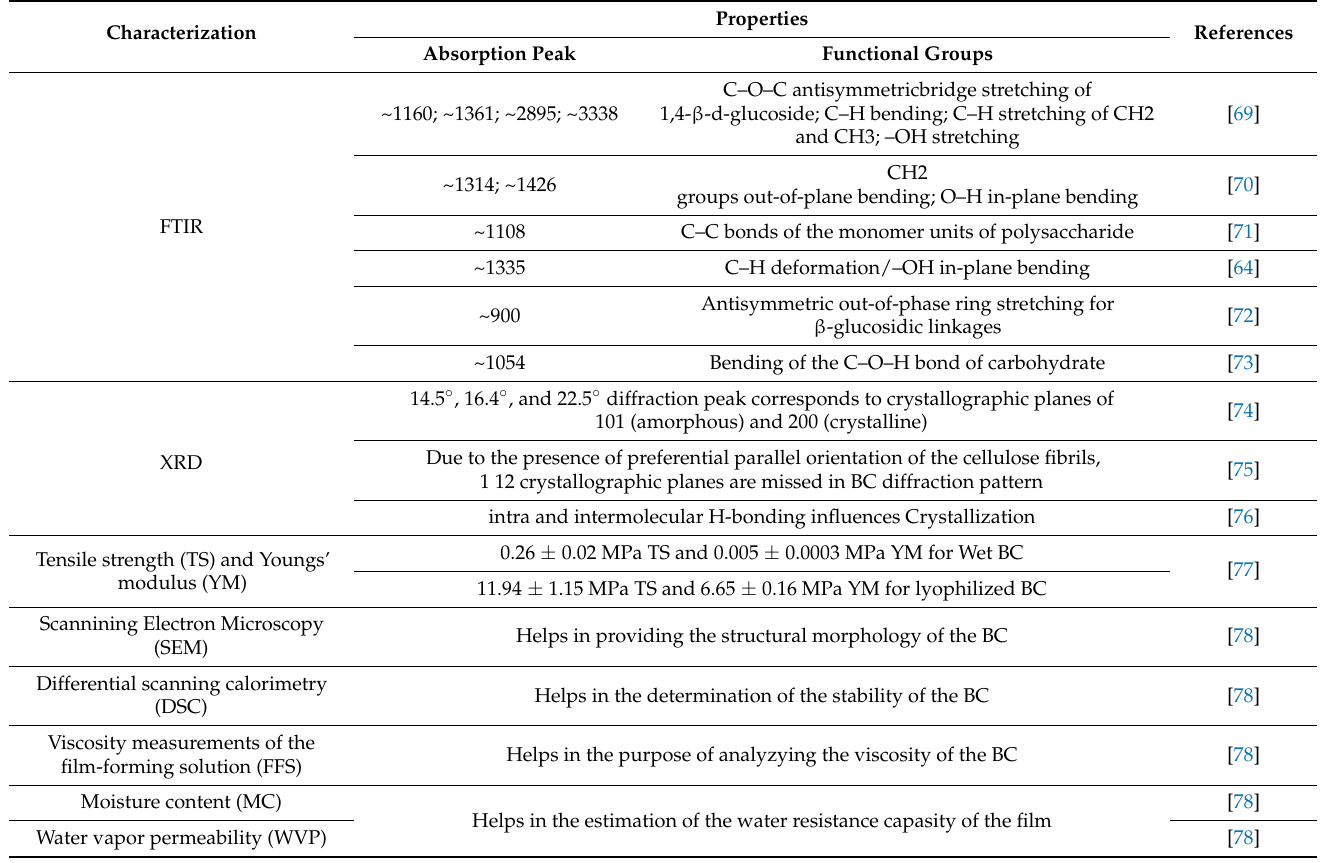
Table 2. Characterization of BC and its